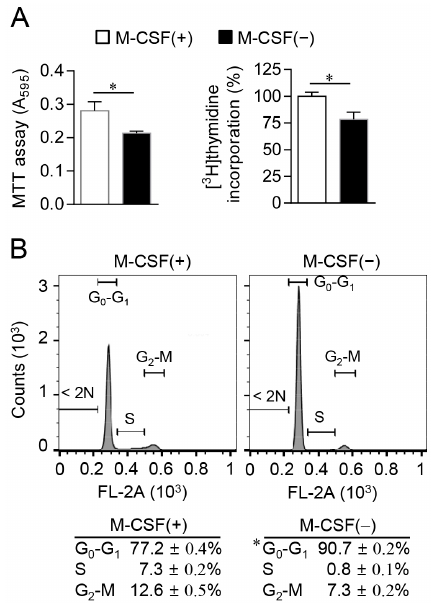
Figure 2. Induction of G 0 –G 1 cell cycle arrest in osteoclast progenitors by M-CSF deprivation. ( A ) Cells were cultured in the absence or presence of M-CSF for 12 h, after which cell proliferation was determined with the MTT assay ( left panel ) or by measurement of [ 3 H]thymidine incorporation ( right panel ); ( B ) Cells cultured as in ( A ) were stained with propidium iodide and subjected to cell cycle analysis by flow cytometry. Data are means ± SD for a representative experiment run in triplicate. * p < 0.01 (Student’s t test).